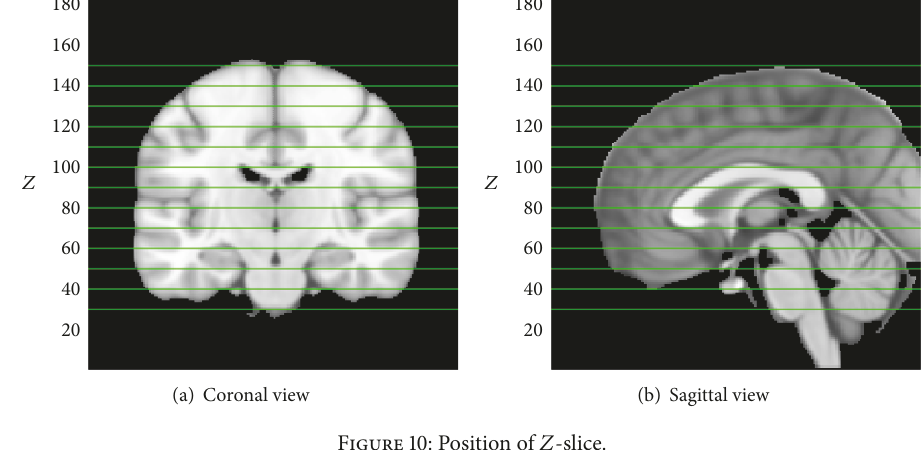
Figure 10: Position of 𝑍 -slice.